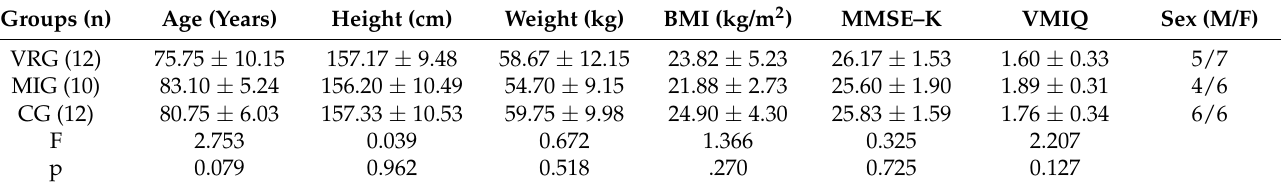
Table 1. General characteristics of the participants (n = 34).